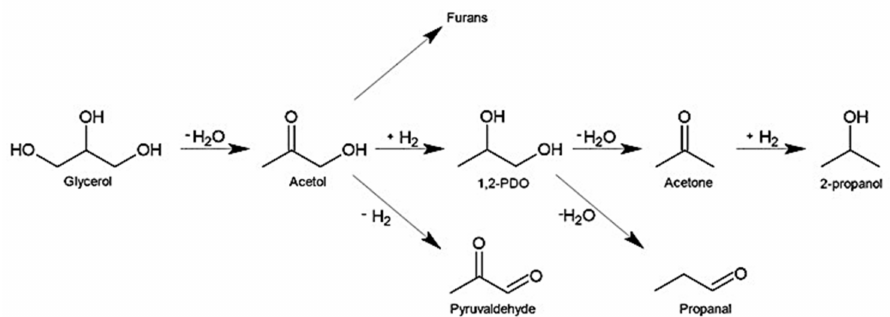
Figure 8. General chemical pathway proposed for catalyzed glycerol